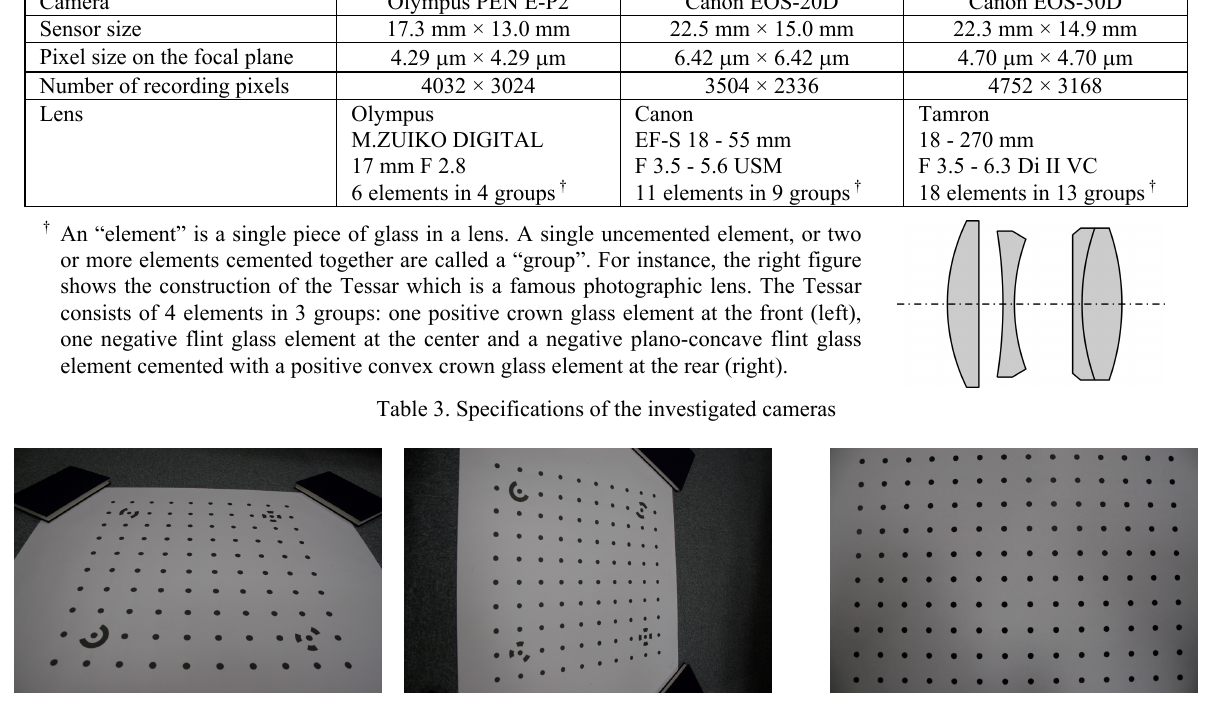
Figure 1. Images for correction parameter estimation Figure 2. Image for